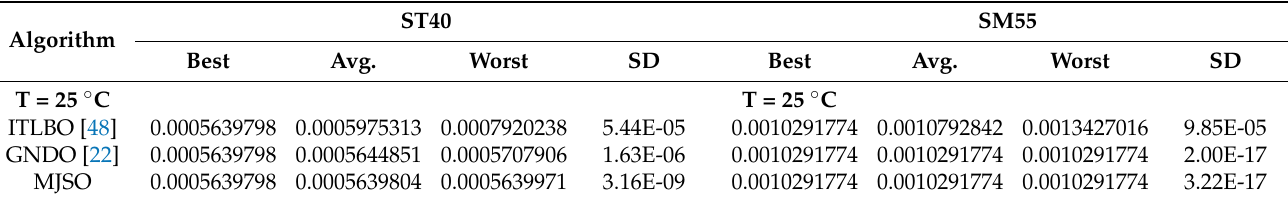
Figure 29. Convergence curve under different operating conditions. Table 18. Comparison among Improved Teaching Learning-Based Optimization (ITLBO), generalized normal distribution optimization (GNDO), and MJSO at G = 1000 W/m 2 and various T.